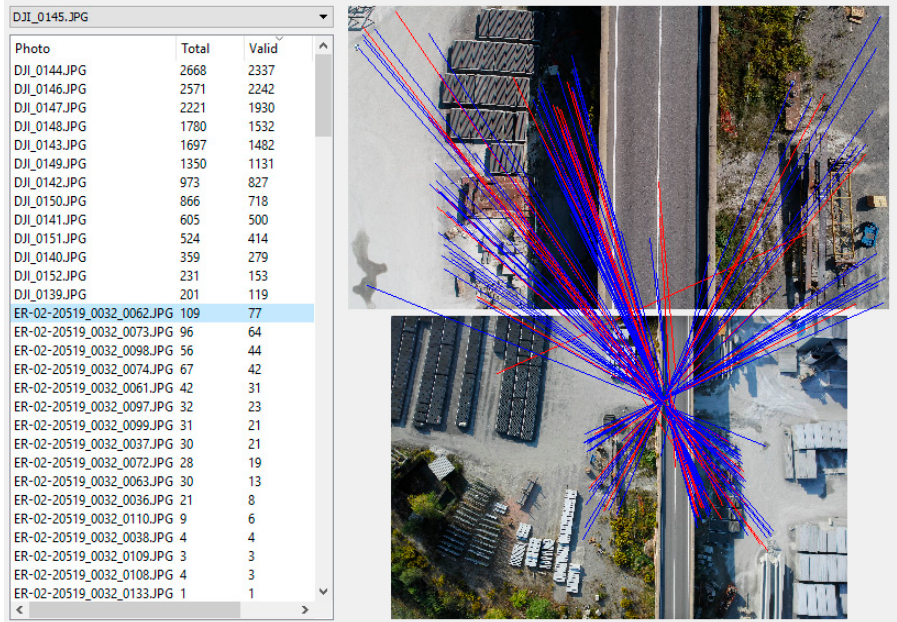
Figure 5. E ffi ciency of tie point extraction across auxiliary and master block. Left: total and valid number of matches between Phantom4 image 0145 and the images of the joint P4 30 and eBee block. Right: valid (blue) and invalid (red) matches across Phantom4 image 0145 and eBee image 0032_0062.